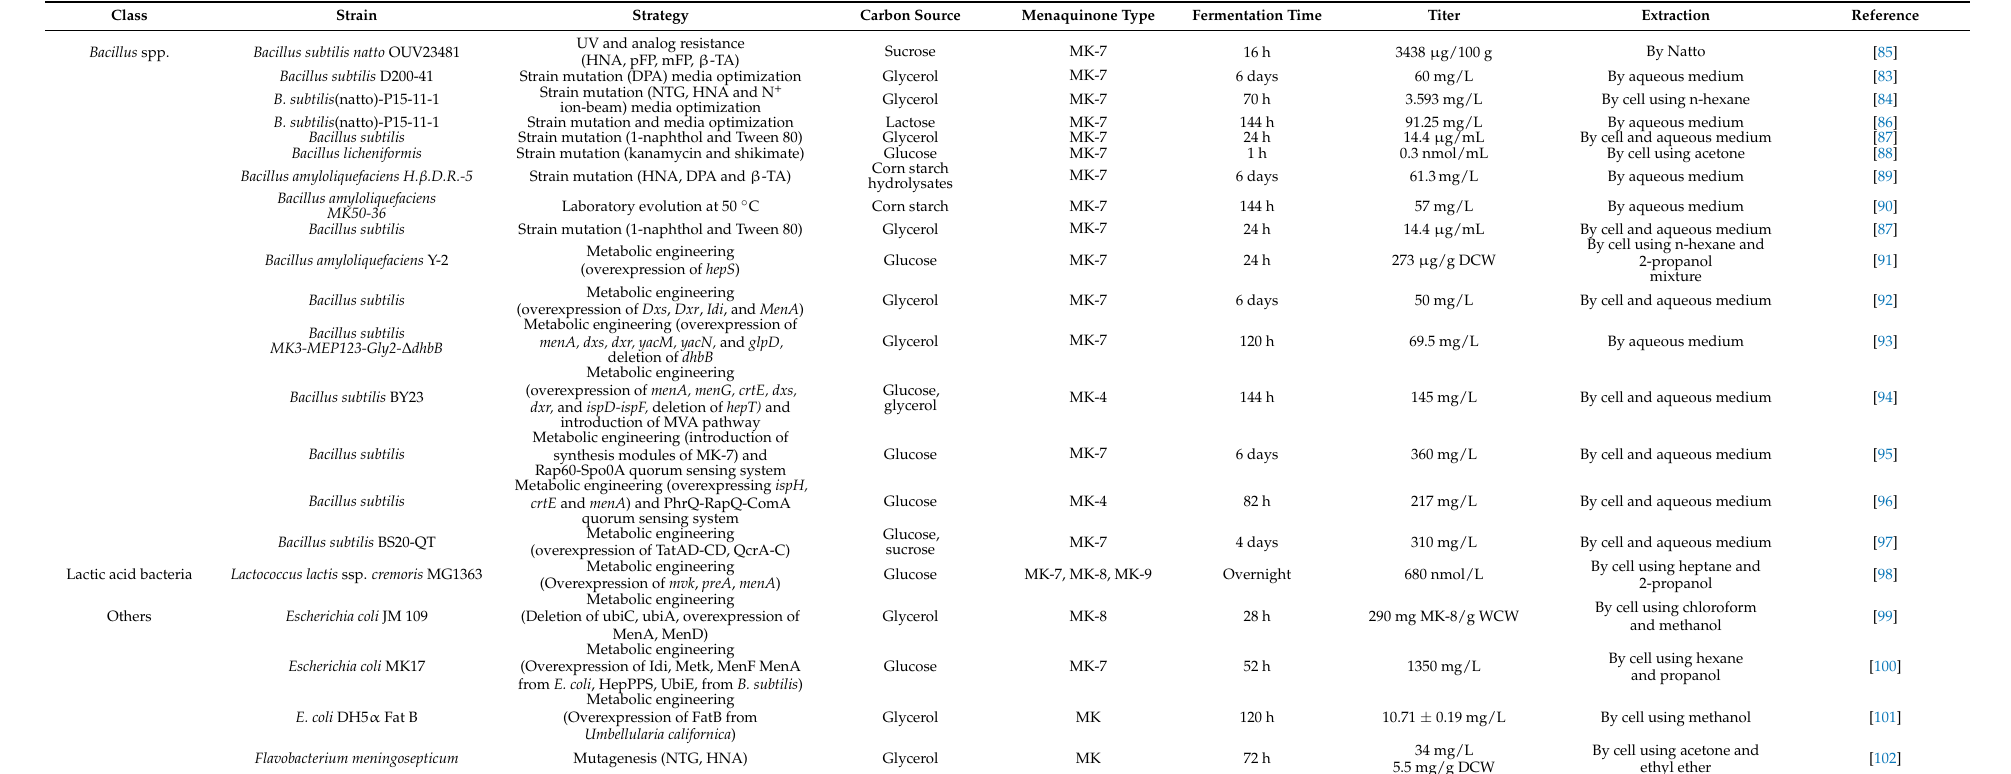
Table 2. Production of vitamin K2 using engineered